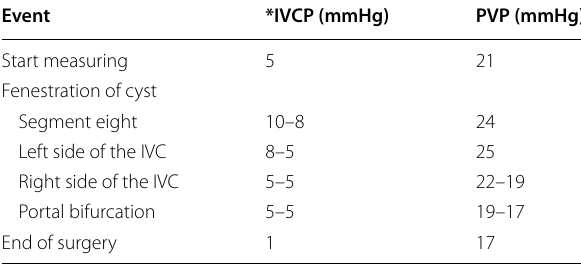
Table 2 Intraoperative changes in CVP (IVCP) and PVP